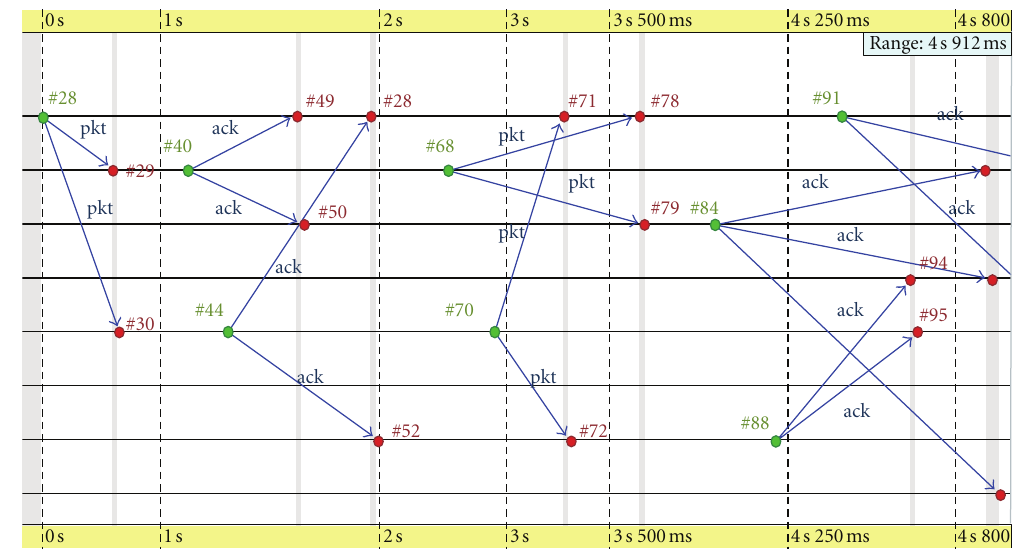
Figure 9: Network timing monitoring view.